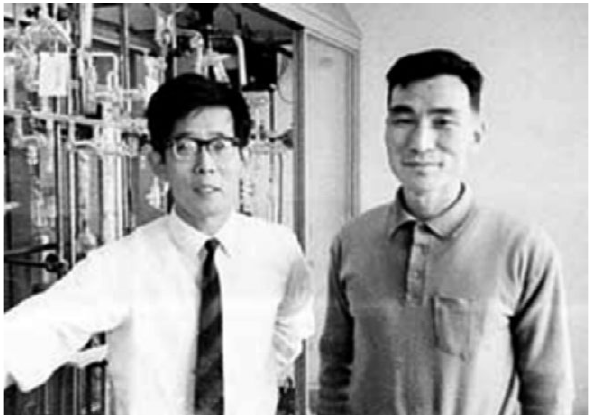
Figure 2. Hideki Shirakawa and Hyung Chick Pyun (1926-2018) at Tokyo Tech in 1967 [Courtesy of Joongmoo